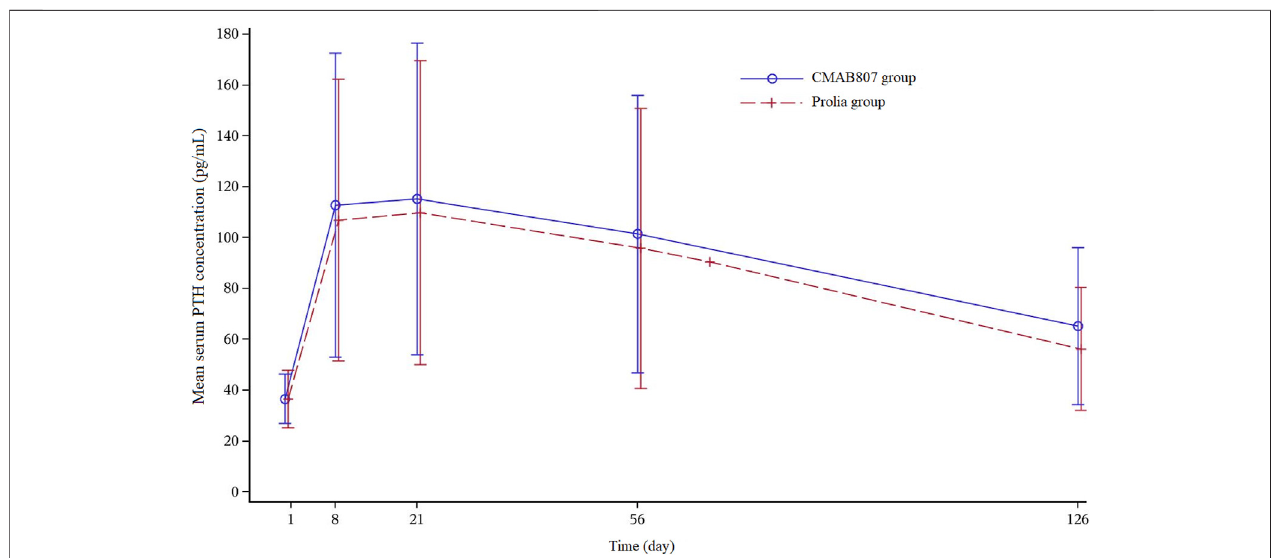
FIGURE 4 | Mean serum PTH concentration versus time pro fi les after the SC injection of 60 mg of CMAB807 or denosumab in healthy Chinese male subjects. Note: the error bars indicate the SD.